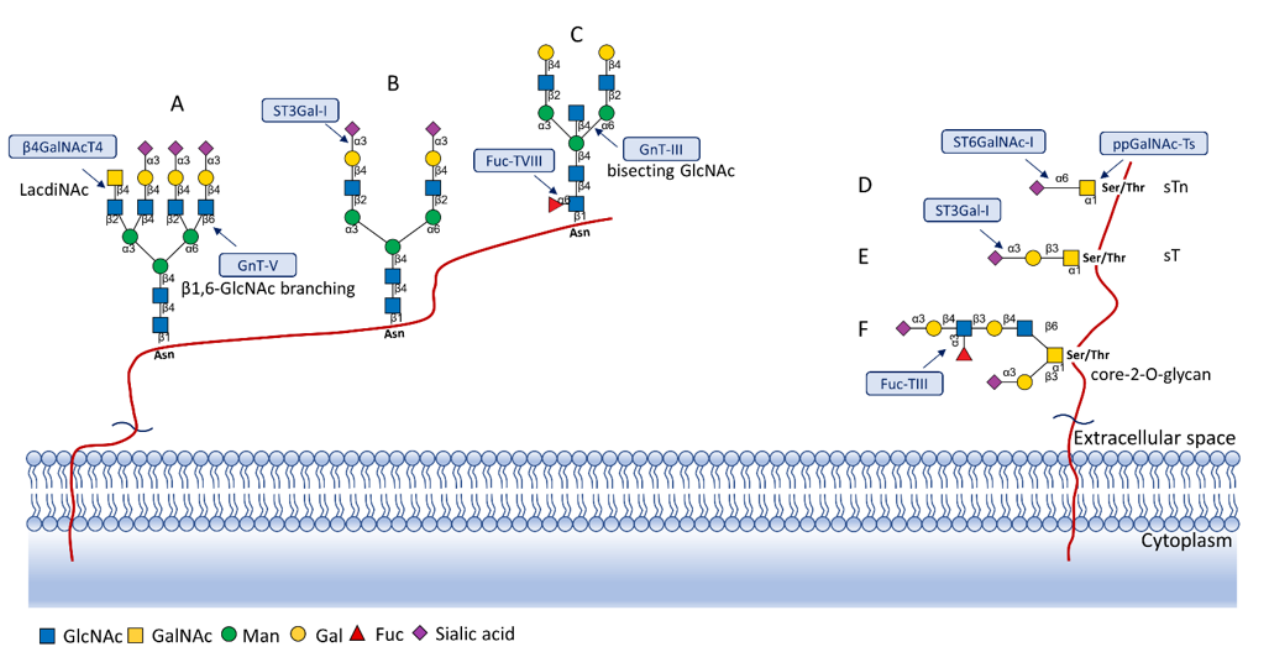
Figure 1. Overexpressed glycan structures typical for PCa. ( A ) Highly branched (tetra-antennary) N-glycan with LacdiNAc motif; ( B ) Biantennary N-glycan terminated with α 2,3-linked SA; ( C ) Biantennary N-glycan with core fucose and bisecting GlcNAc; ( D ) sTn truncated O-glycan; ( E ) sT O-glycan antigen; ( F ) core-2-O-glycan with sLe X antigen. Blue boxes indicate glycosyltransferases involved in the synthesis of particular structures.